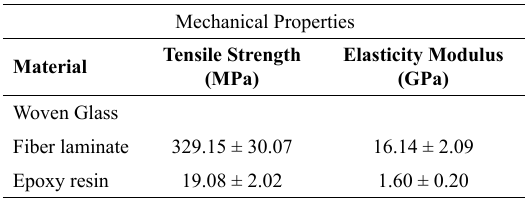
Table 1. Mechanical properties- woven glass fiber laminate and epoxy resin – tensile